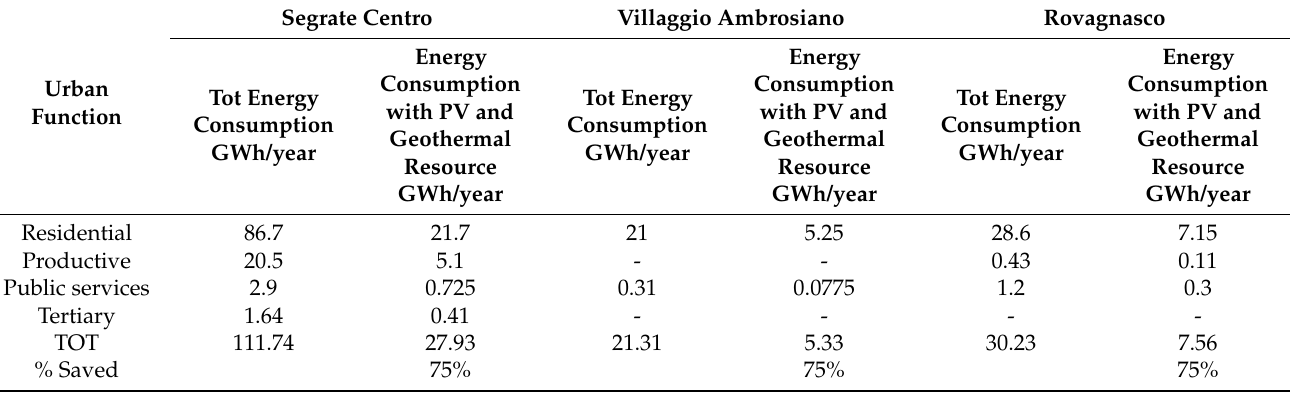
Table 5. Energy consumption with a low-temperature geothermal system in the case study’s neigh- borhoods.